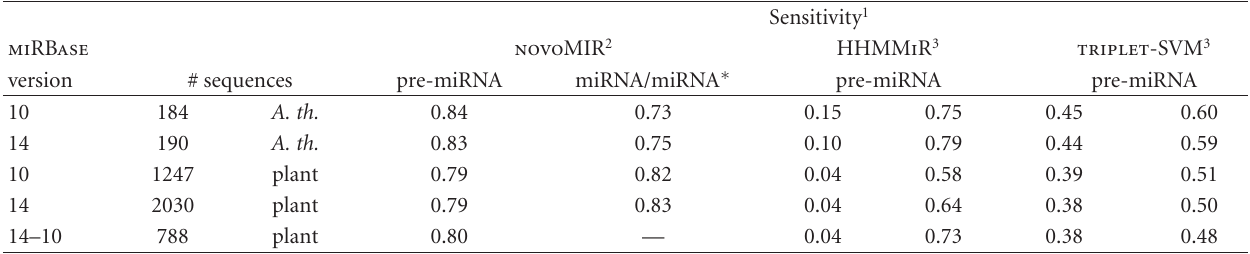
Table 1: Sensitivity of novoMIR , triplet-SVM [14], and HHMMiR [13] in pre-miRNA prediction for di ff erent versions of miRBase . The row “14–10” shows values for sequences from miRBase 14 which are not present in miRBase